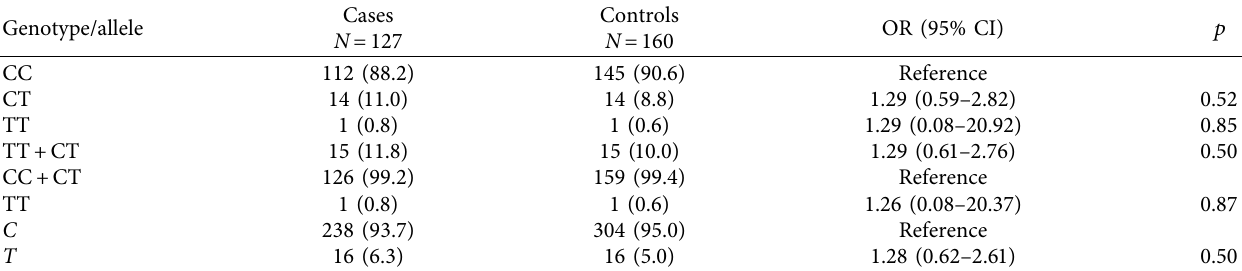
Table 2: Distribution of C677T MTHFR polymorphism in the breast cancer group according to genetic models.